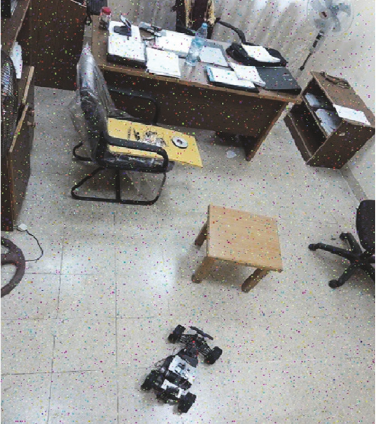
Figure 23: Noisy tested image.